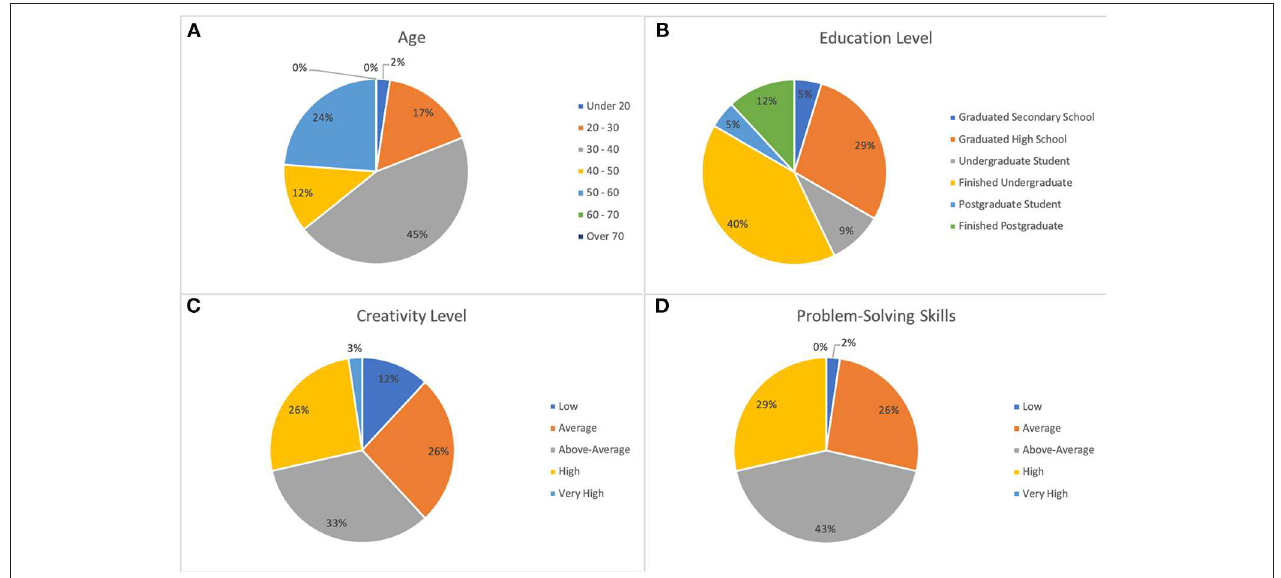
FIGURE 3 | Demographic distribution of Study-1 participants. (A) Age. (B) Education level. (C) Creativity level. (D) Problem-solving